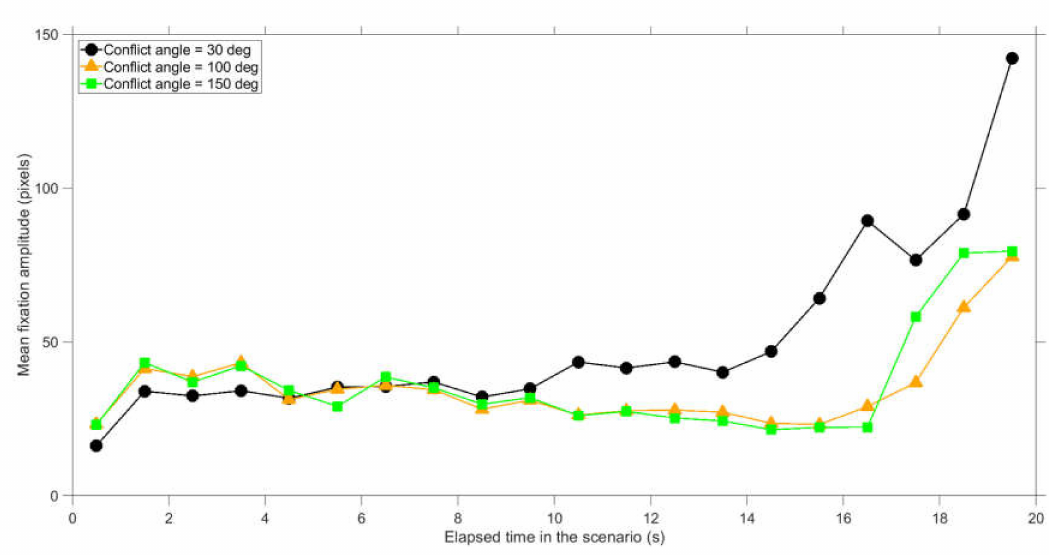
Figure 11. Mean fixation amplitude per conflict angle, where the end moments of saccades are divided into 1 s bins since the start of the scenario. The shown values represent averages for 35 participants and 12 scenarios per participant (conflict scenarios and non-conflict scenarios